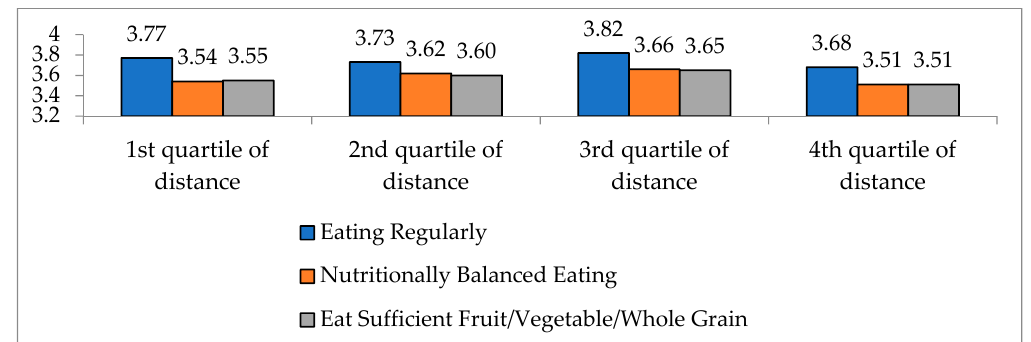
Figure 8. Eating habits by quartile of distance to the nearest grocery store. Note: p -value = 0.000 in t-test Source: Consumer Behavior Survey for Foods [38].